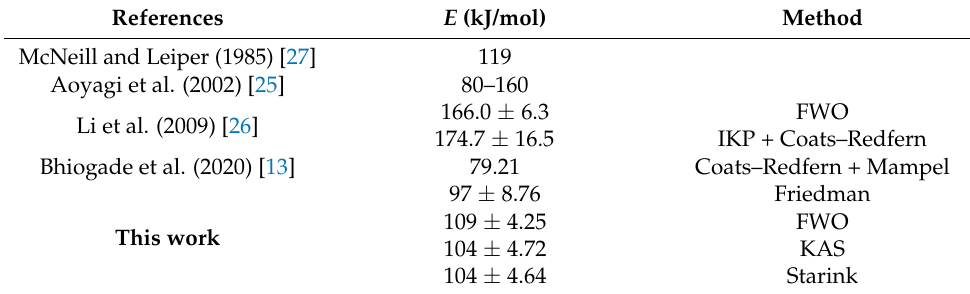
Table 9. Reported values of activation energies of the PLA pyrolysis.